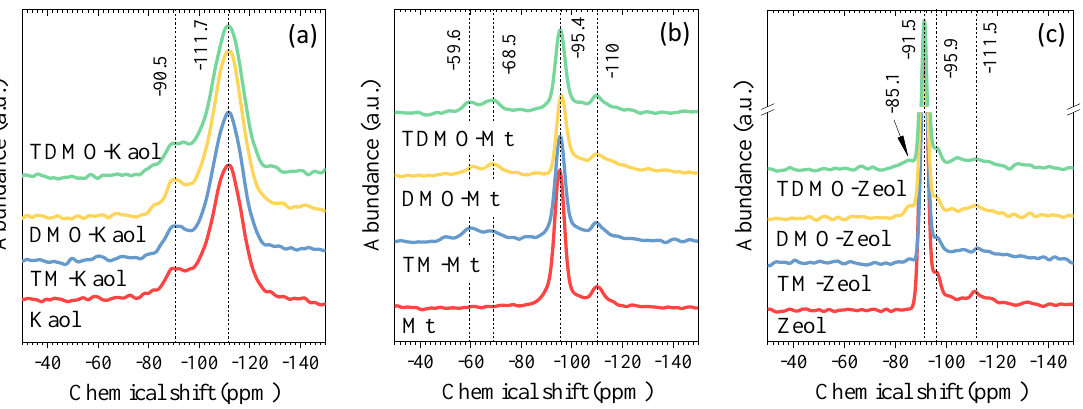
Figure 4. Solid − state 29 Si − NMR spectra of the original and grafted ( a ) Kaol, ( b ) Mt, and ( c ) Zeol.